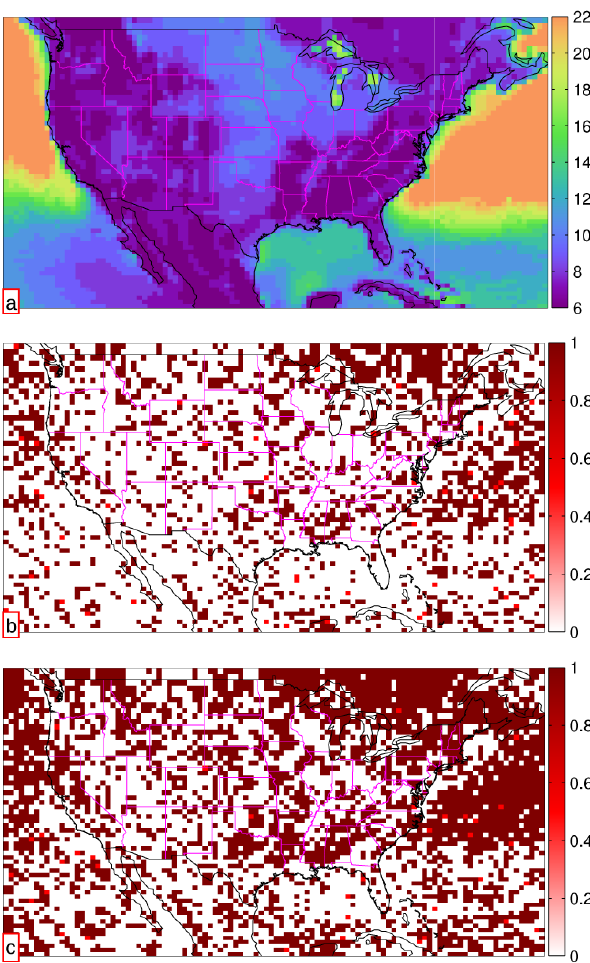
Fig. 15. Geographical variation of the median wind power episode length (h) at different heights. (a) shows median wind power episode length at (80m) and, (b) and (c) show the difference WPD episode length at 100m and 120m from that at